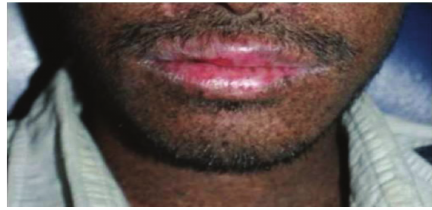
Figure 5: Actinic cheilitis of upper and lower lips.